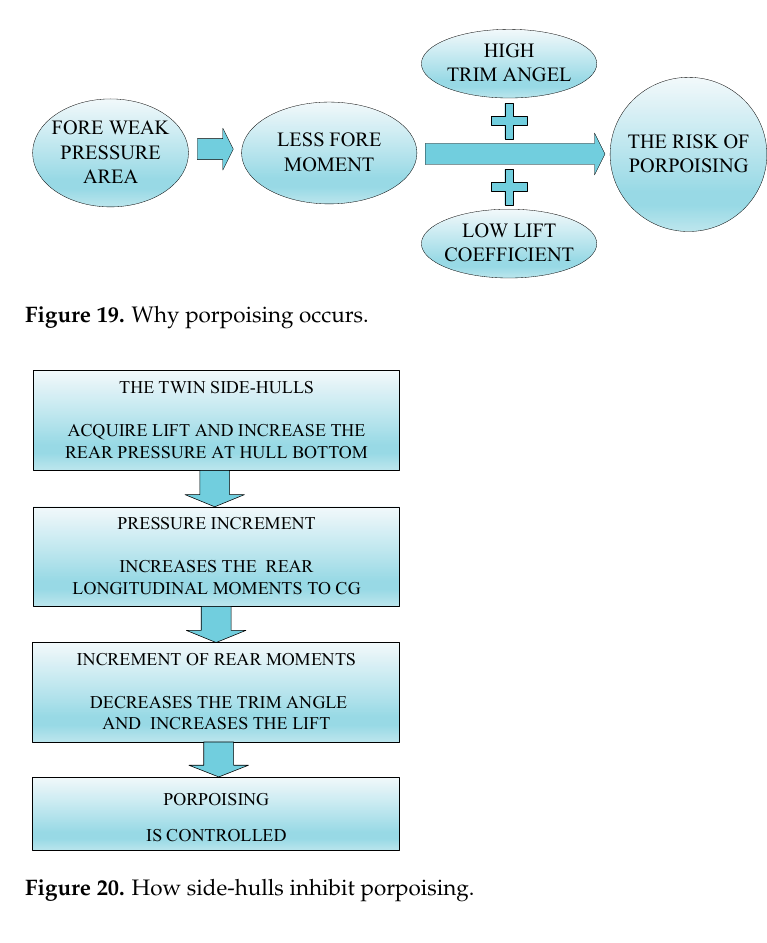
Figure 20. How side ‐ hulls inhibit porpoising.